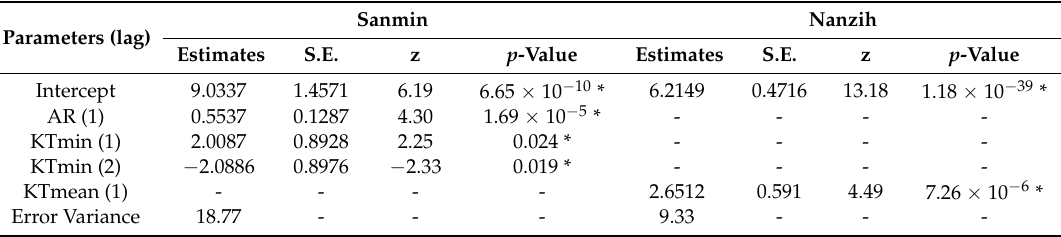
Sanmin (Supplementary Table S4 [online only]) and Nanzih (Supplementary Table S5 [online only]). Parameter estimates for the best time series models for Ae. aegypti are presented in Table 1. Table 1. Parameter estimates for the best time series explaining abundance changes in Aedes aegypti sampled with BG-sentinel traps at Sanmin (dengue transmission hotsop) and Nanzih (dengue transmission coldspot), Kaohsiung City, Taiwan. In parameters, Intercept is the mean value of the time series and AR = autoregressive term, K = kurtosis, T = temperature, mean = average and min = minimum. Lags are in biweeks.